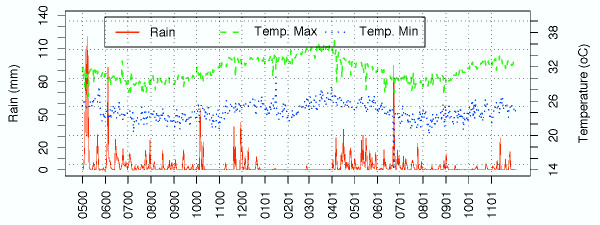
Rainfall and Temperature